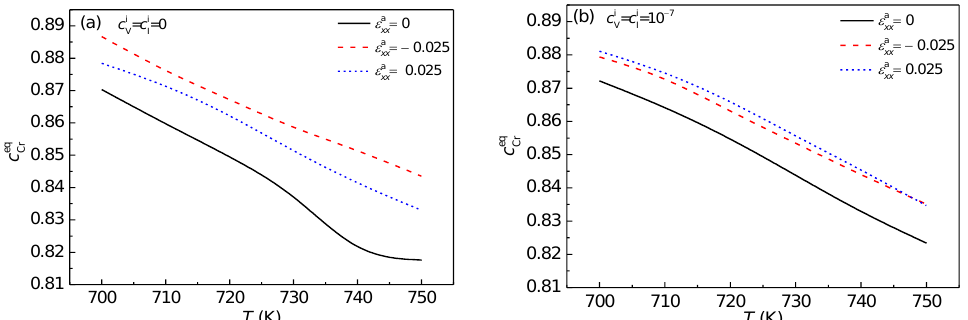
= c i = 0, ( b ) c i = c i = 1 × 10 − 7 . V I V I